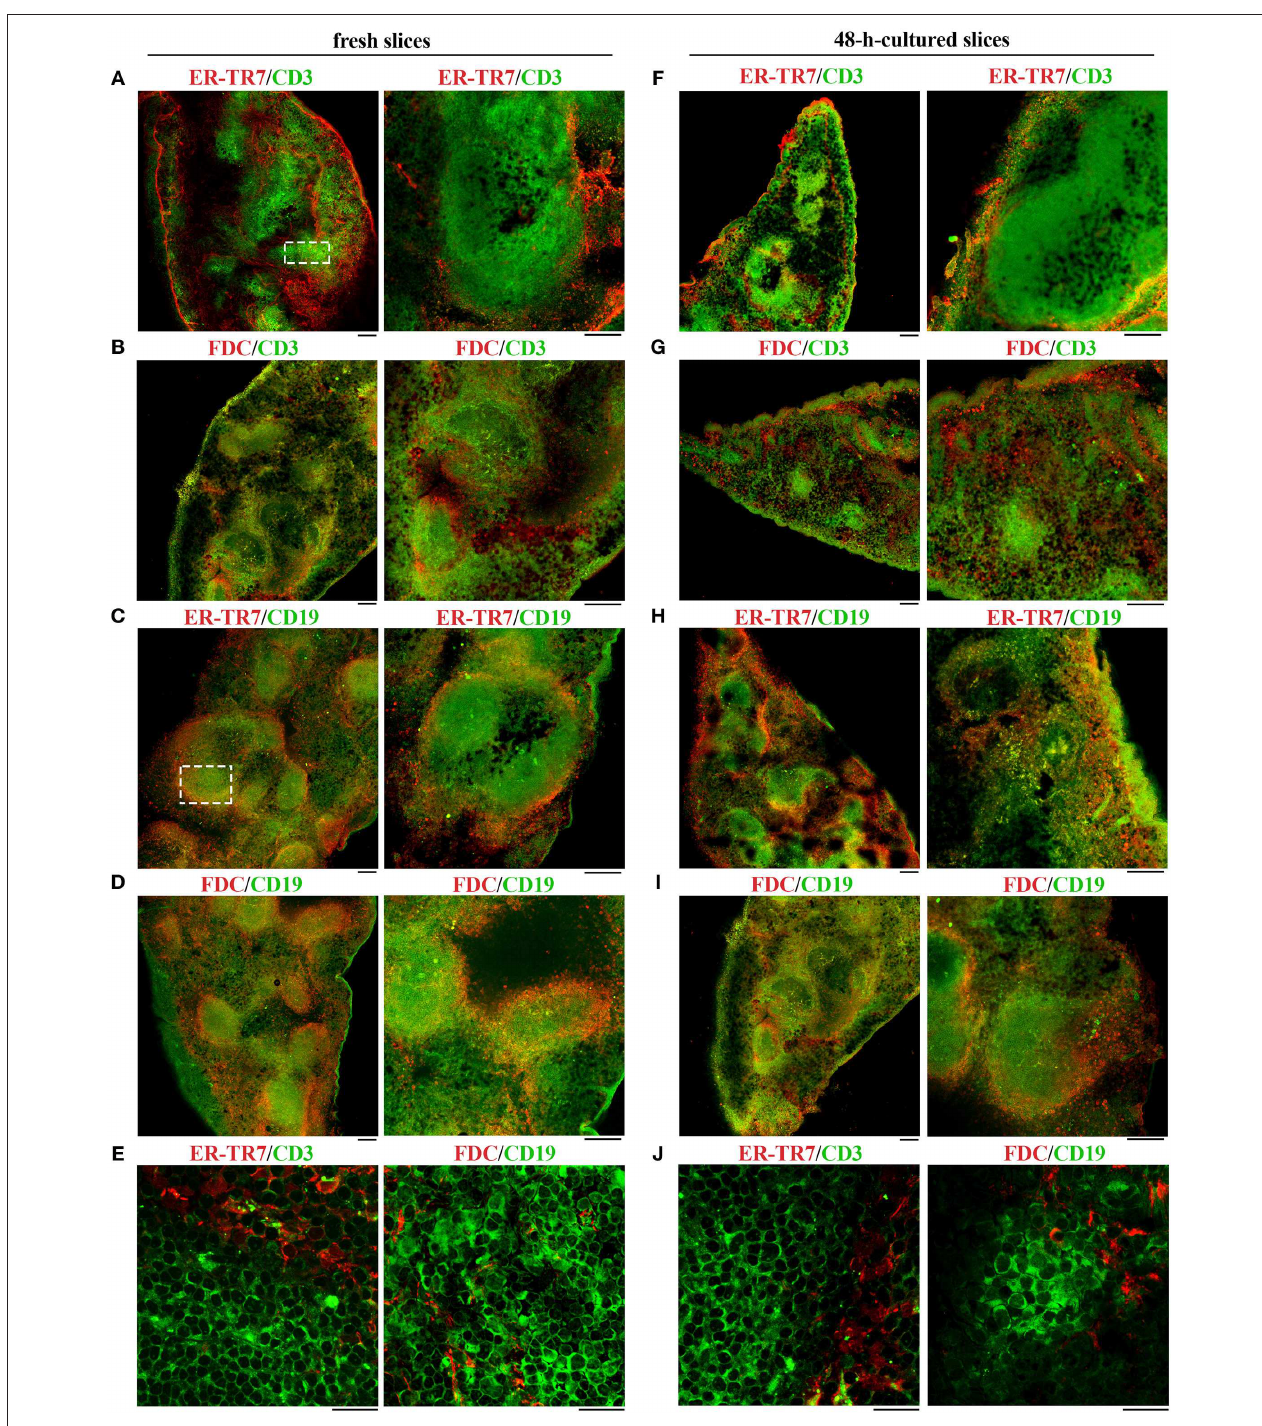
FIGURE 5 | 48 h-culture does not alter the distribution of cell populations in spleen slices. Immunofluorescence analysis of spleen slices either immediately after cutting (fresh slices, A – E ) or cultured in vitro for 48h (48-h-cultured, F – J ), permeabilized and labeled for ER-TR7 (red)/CD3 (green) (A,E,F,J) , ER-TR7 (red)/CD19 (green) (C,H) , FDC marker (red)/CD3 (green), (B,G) or FDC marker (red)/CD19 (green) (D,E,I,J) . The pictures refer to non-contiguous spleen slices. Median optical sections are shown. Size bar, 100 µ m (A–D,F–I) , and 20 µ m (E,J) .